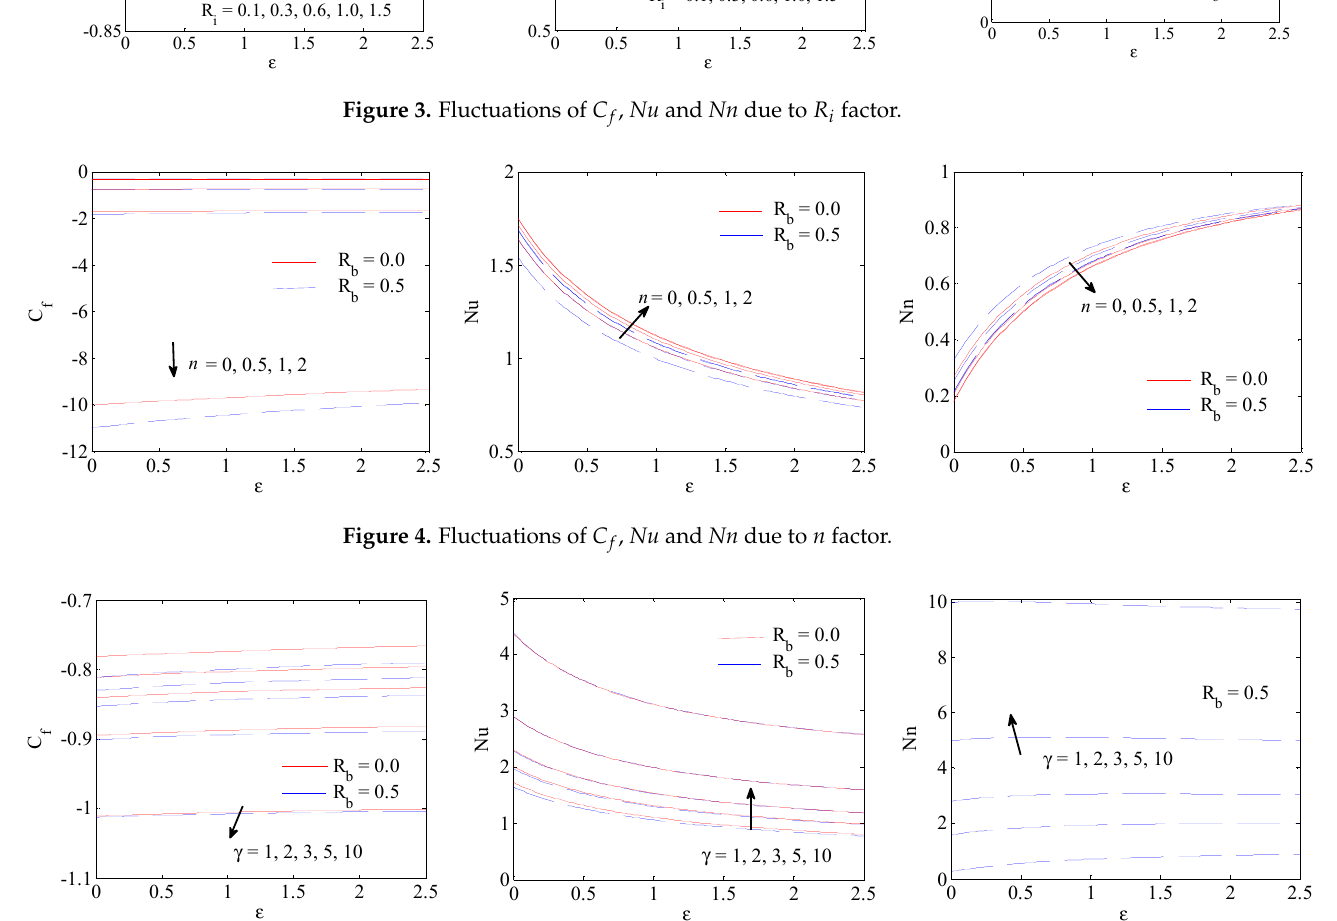
Figure 5. Fluctuations of C (cid:2916) , Nu and Nn due to γ factor.